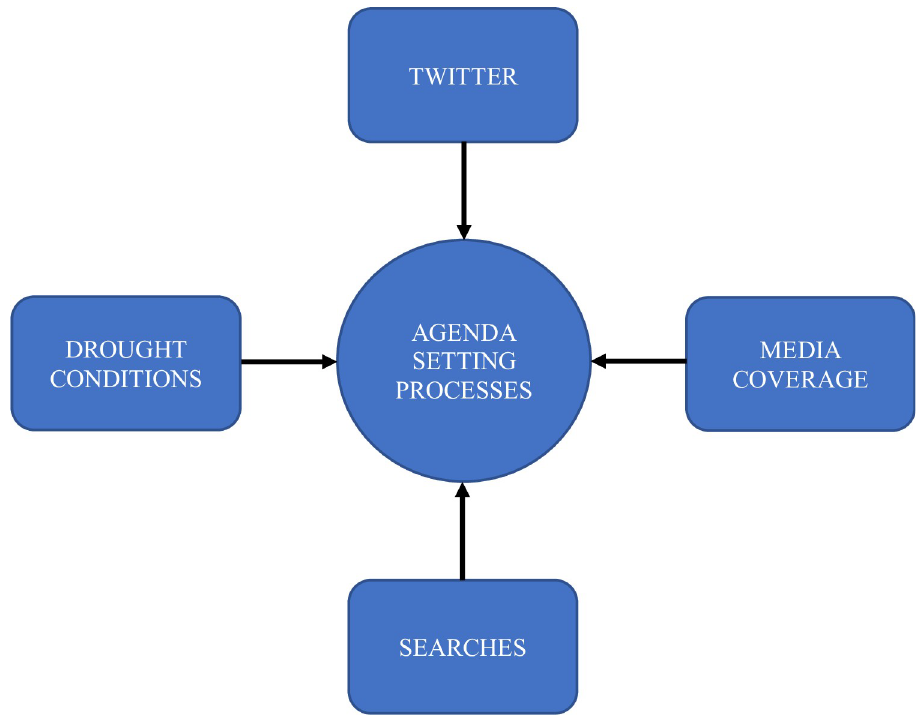
Fig 1. Interactions between communication elements in the California drought are currently undefined.